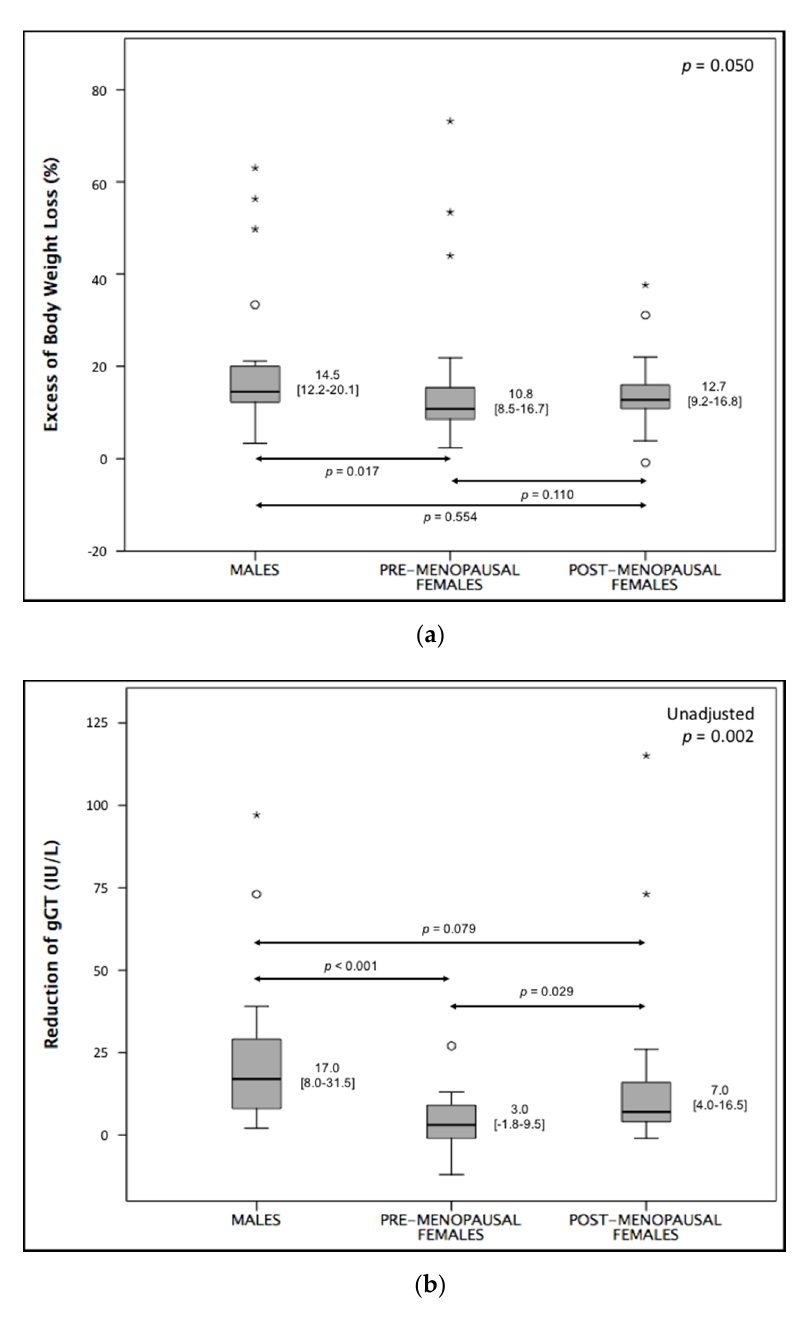
Figure 3. Comparison of ( a ) excess of body weight loss (EBWL) and ( b ) reduction in gamma ‐ glutamyl transferase (gGT) between males, pre ‐ menopausal females, and post ‐ menopausal females (Kruskal–Wallis test). * and depict outliers.